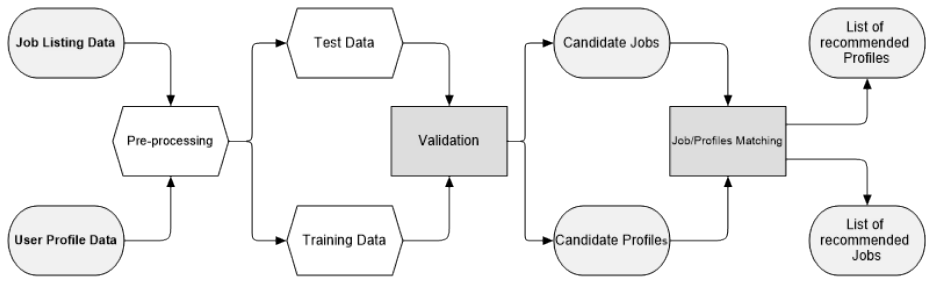
Figure 1. Bi-directional recommender system